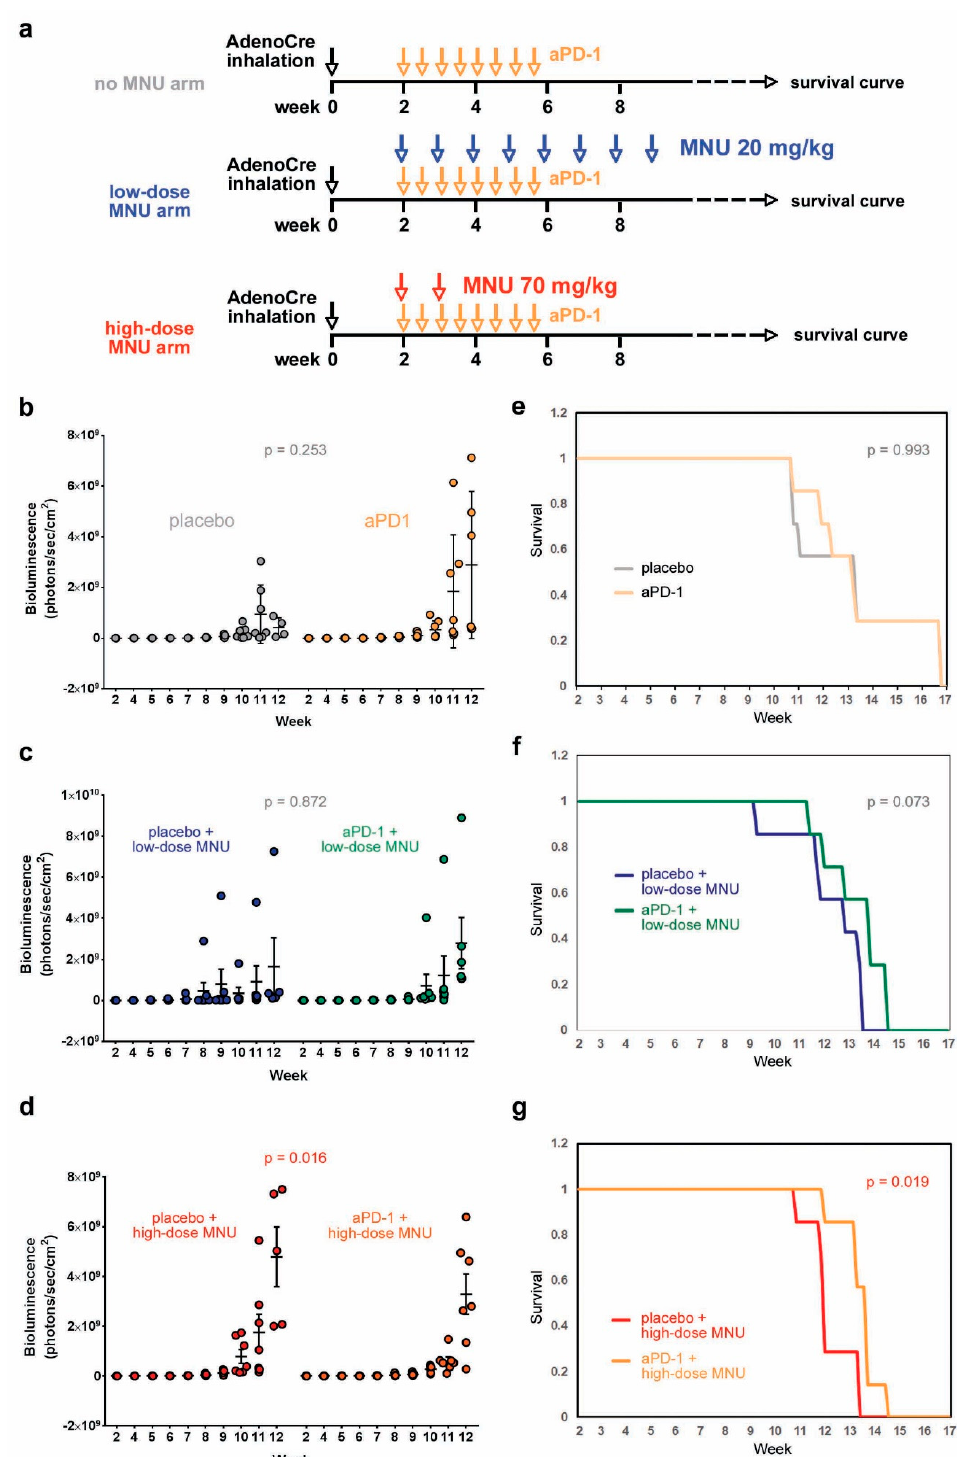
Figure 4 . MNU treatment improves the response of KP tumors to anti-PD-1 treatment. ( a ) Tumors were induced in KP mice by AdenoCre inhalation. Two weeks after tumor induction, the mice were treated with either placebo or anti-PD-1 in the absence or presence of two regimens of MNU (low-dose or high-dose). ( a , b ) Treatment of KP mice with aPD-1 without MNU exposure. ( b – d ) Tumor burden measurements at different time points, as indicated: no-MNU arm ( b ), low-dose MNU arm ( c ), and high-MNU arm ( d ). ( e – g ) Survival curves constructed with the Kaplan–Meier method: no-MNU arm ( e ), low-dose MNU arm ( f ), and high-MNU arm ( g ). The statistical significance was evaluated for the tumor burden data with a GEE model, for the survival curves with the log-rank